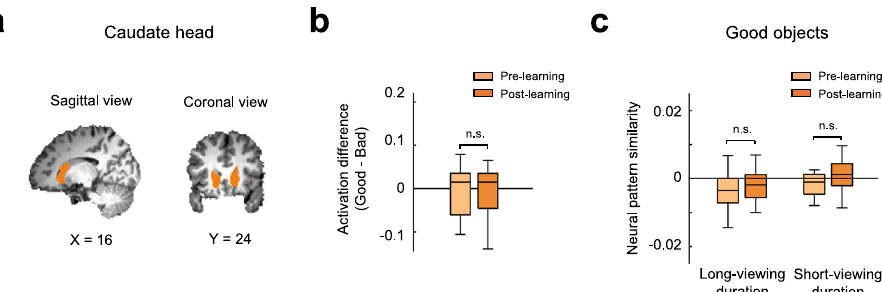
Fig. 6 BOLD responses and representational change in the human caudate head. a The caudate head (Orange) delineated on the MNI brain. b The difference in the response magnitude between the good and the bad objects during the Pre-learning and Post-learning sessions. c Neural pattern similarity during the Pre-learning and Post-learning fMRI sessions for the long-viewing-duration (left) and for the short-viewing-duration (right) participant groups in the free-viewing task. n.s. not signi fi cant. In b and c , the middle line indicates the median, and the bottom and the top of the box correspond to the 25th and 75th percentiles, respectively. The upper and lower whiskers extend to the highest and lowest values that are within 1.5 times interquartile range of the hinge. Outlying data beyond this are plotted as dots ( n = 22 participants, two-tailed paired VS plays a role in automatic evaluations of objects based on the neural representation of positive values retained since learning, to guide habitual seeking behavior.